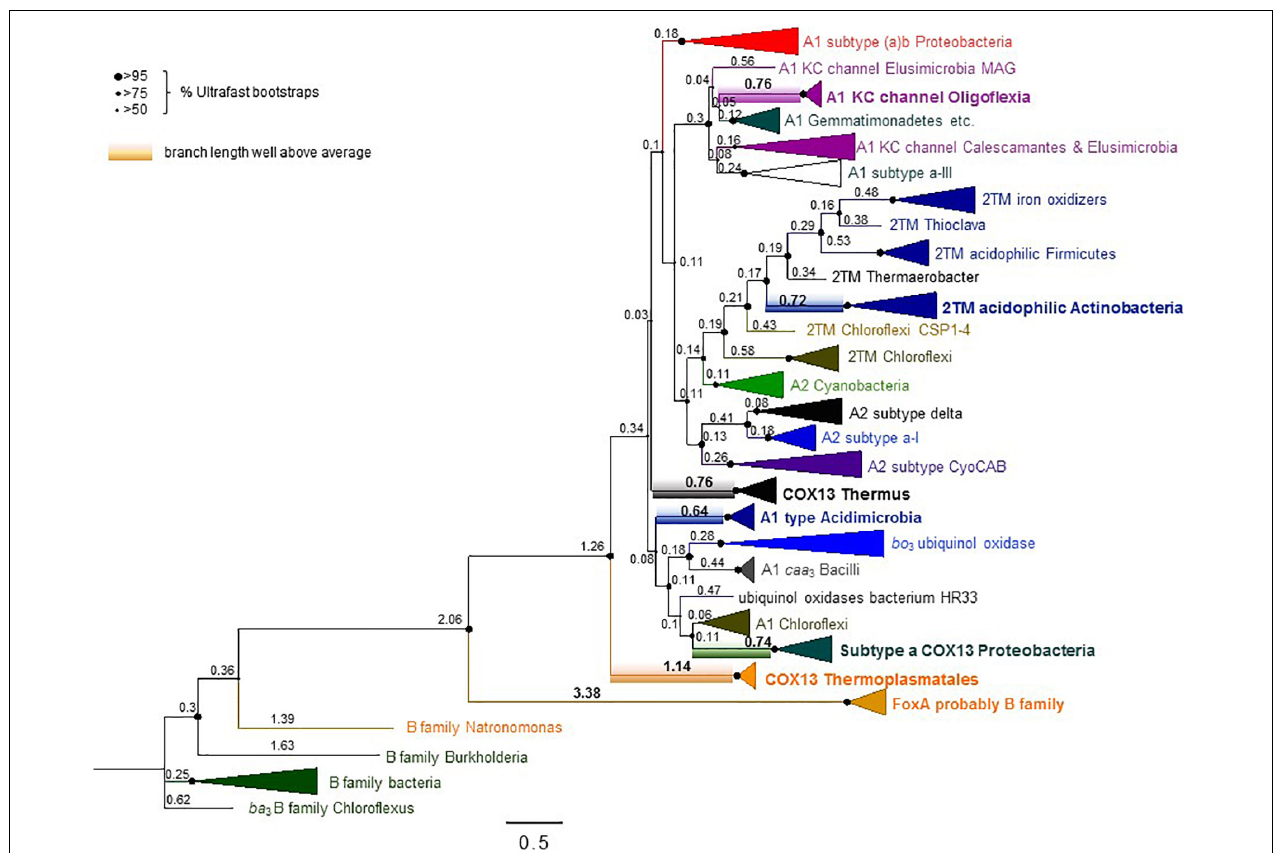
FIGURE 6 | Extended phylogenic tree of COX1 from many bacteria and Thermoplasmatales archaea. The ML tree was obtained with the program IQ-Tree using an alignment of 100 COX1 sequences from family A and B oxidases encompassing most subclades analyzed here ( Supplementary Table 1 ). The alignment had 607 amino acid sites and was analyzed with the LG model. Similar trees were obtained with a slightly more trimmed version of the same alignment ( Supplementary Figure 8a and separate supplementary file COX1refined100IQTreeEX_EHOFigTreefull.pdf), which had stronger values of%Ultrafast bootstraps support (indicated here by the size of the nodes shown on the left of the figure). The focus of this figure is to show the values for the relative branch length of the various subclades, annotated as raw values obtained from the FigTree program. See Supplementary Figure 8b for the statistical analysis of these values. Note the large values of branch length (highlighted in bold numerals) for the clades including the proteins from Thermoplasmatales and similarly COX1-3 fusion proteins from Proteobacteria and Thermus